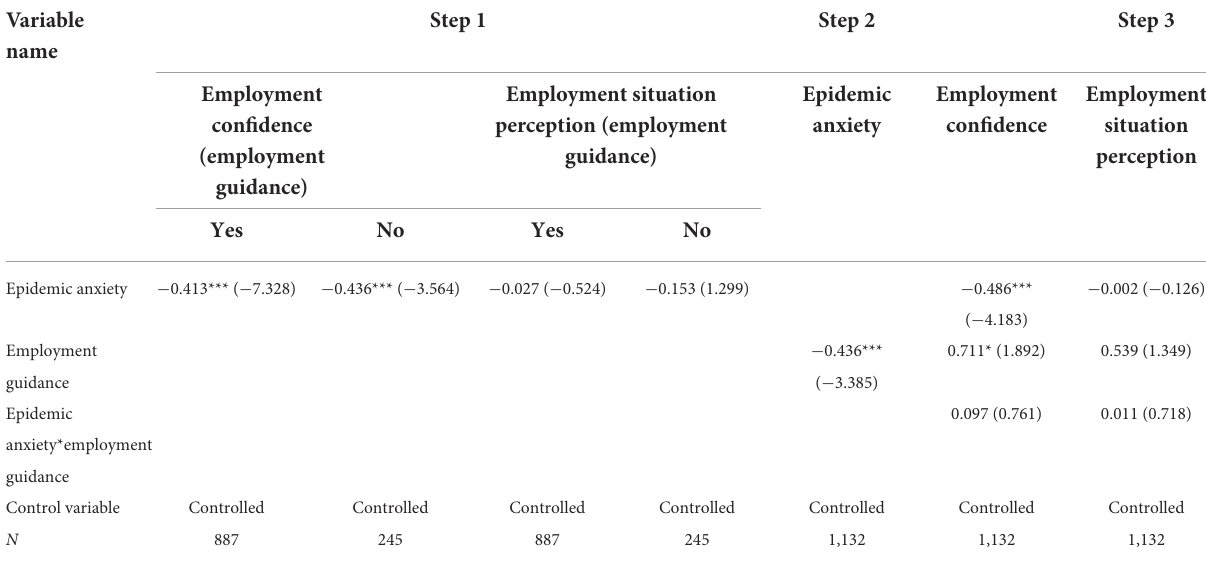
TABLE 5 The moderating effect of employment guidance on employment confidence and employment situation perception.